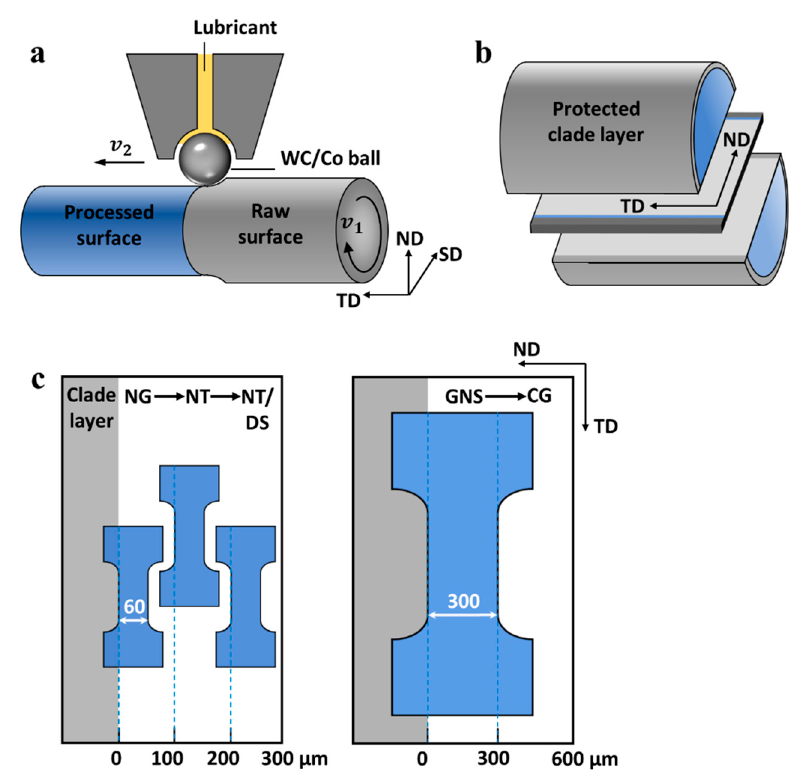
Figure 1. Schematic illustrations of ( a ) the SMRT set-up and the defined specimen coordinate system (shear direction (SD), transversal direction (TD), normal direction (ND)), and ( b , c ) sampling positions for the NG, NT, NT/DS, and GNS specimens.